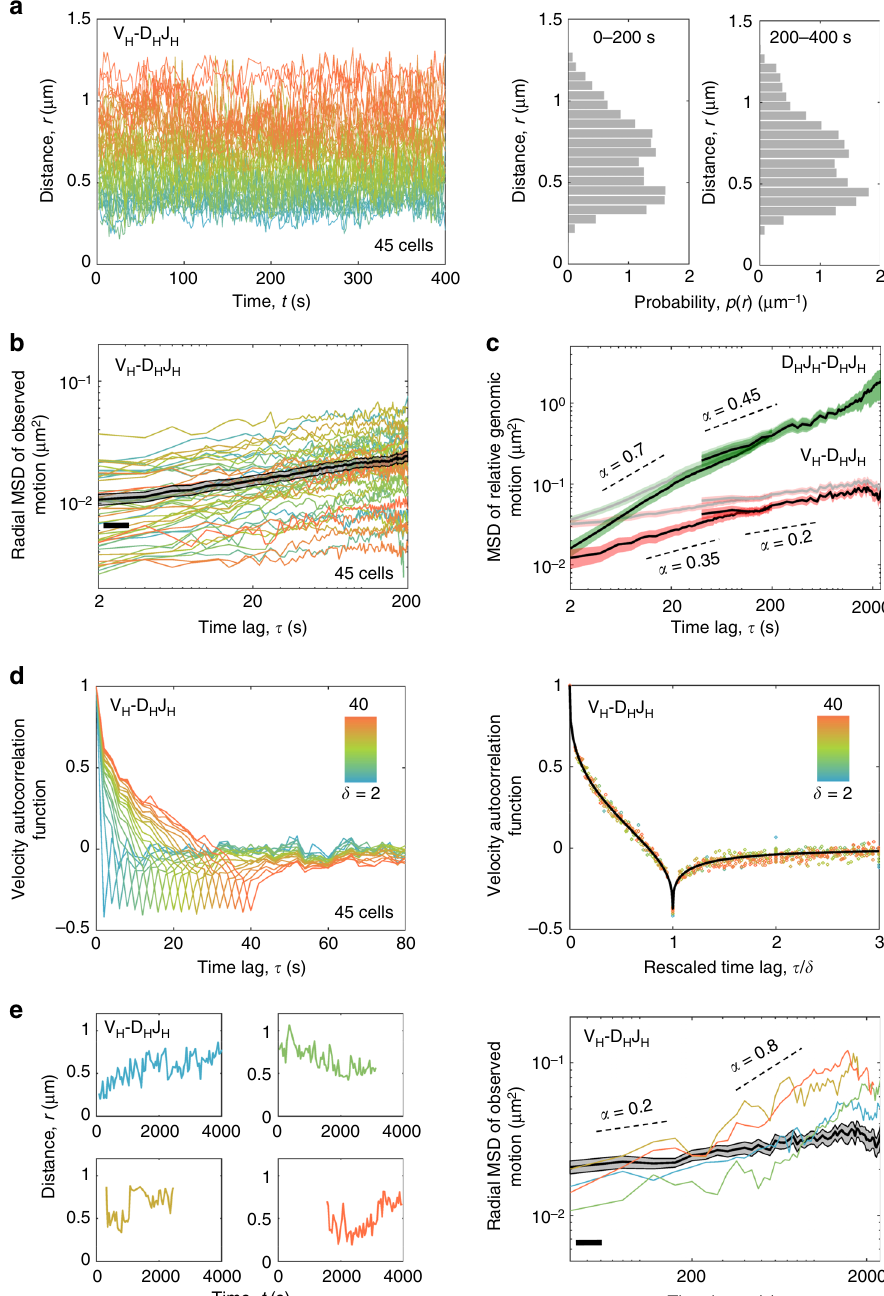
Fig. 3 V H -D H J H motion in B-cell progenitors is extremely con fi ned. a The spatial distances separating V H and D H J H elements for the majority of cells fl uctuated around their respective average values that remained nearly constant over time. Color-coding the distance trajectories according to their mean values reveals a “ demixing ” effect. Right panel shows the corresponding probability distribution of V H -D H J H distances. b The time-averaged radial MSD (colored lines) and the time-and-ensemble-averaged radial MSD (black line) for V H -D H J H motion. c Time-and-ensemble-averaged MSD of relative genomic motion for inter-chromosomal D H J H -D H J H pair (green) and intra-chromosomal V H -D H J H pair (red) before (pale lines) and after (bright lines) measurement-error correction. d Velocity autocorrelation functions for the V H -D H J H motion exhibit anti-correlations indicative of a push-back from the environment; the value at the dip approaches the theoretical limit ( − 0.5) of an extreme con fi nement. The collapse of the velocity autocorrelation function curves upon rescaling of the time axis (right panel) indicates self-similarity of motion. Source data are provided as a Source Data fi le. e Left panel shows the V H -D H J H trajectories that, unlike those in a , exhibited substantial changes in their mean values over time. Right panel shows the radial MSD curves (colored lines) for the individual cells that displayed abrupt changes in V H -D H J H motion and, for comparison, the time-and-ensemble-averaged radial MSD (black line) for V H -D H J H motion in the majority of cells. Scaling exponents ( α ) are indicated. Source data are provided as a Source Data